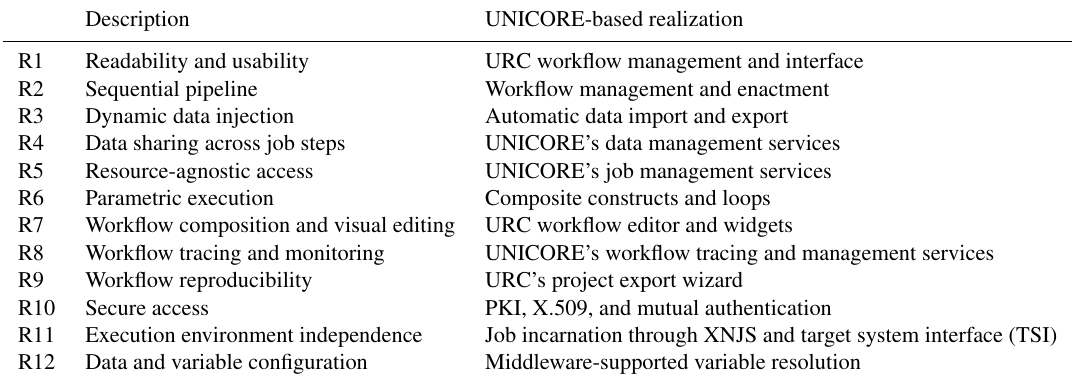
Table 1. Summary of requirements and how the new workflow implementation addresses